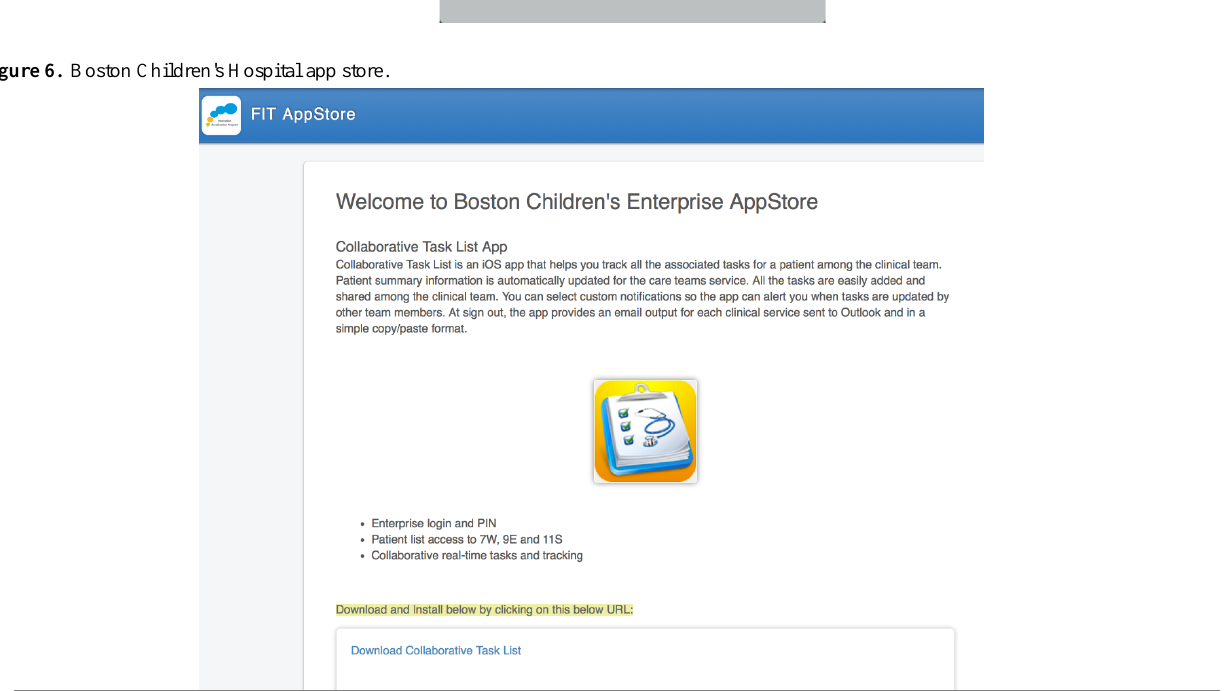
Figure 6. Boston Children's Hospital app